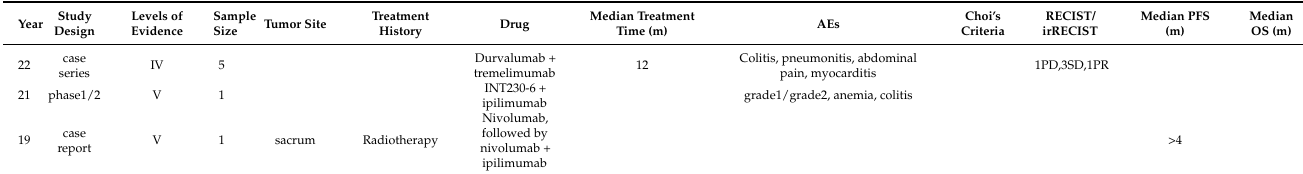
Table 2. Immunotherapy of chordomas with CTLA-4 immune checkpoint